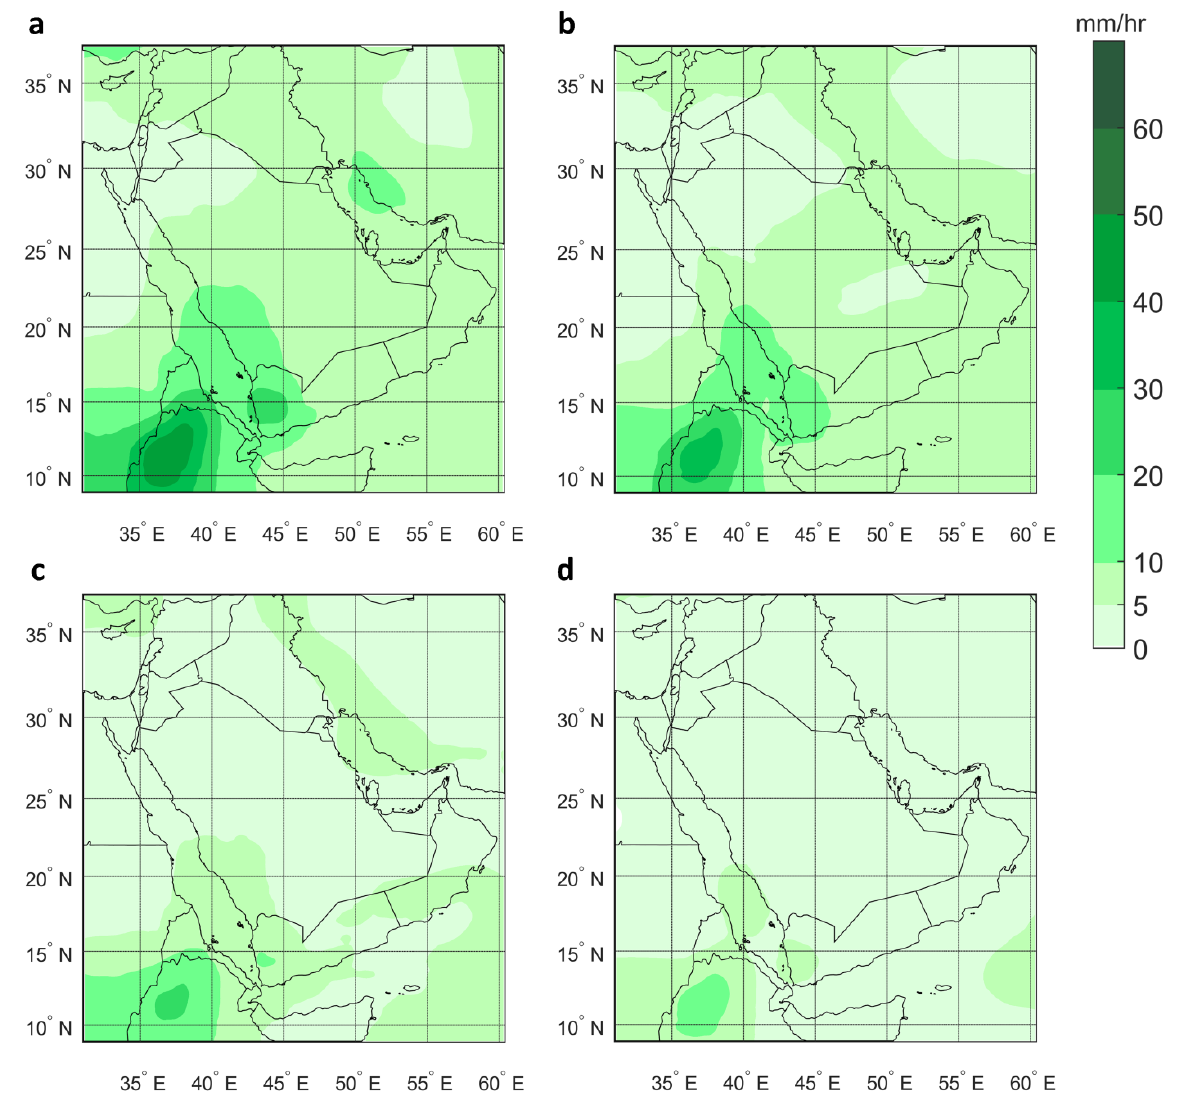
Figure A2. Average rainfall intensity (modeled) for durations of 3, 6, 12 and 24 hours ( a – d , respectively) and a 50-year return period.